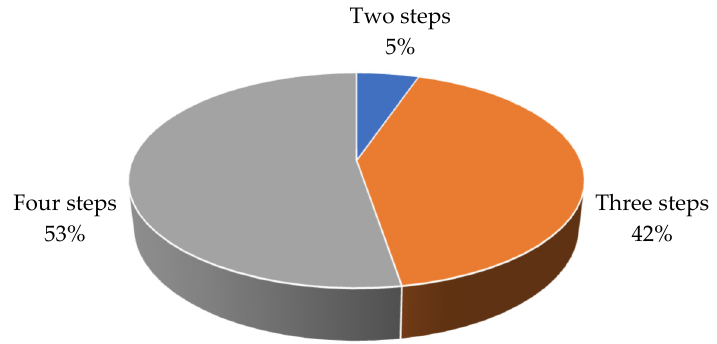
Figure 4. The use of the proposed steps in reviewed literature.